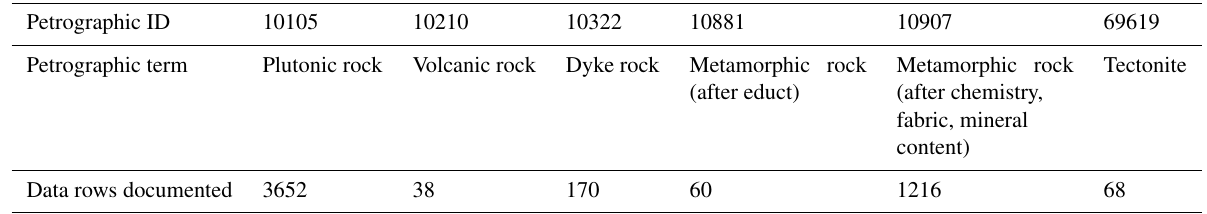
Tectonite Metamorphic rock (after educt) (after chemistry, fabric, mineral content)